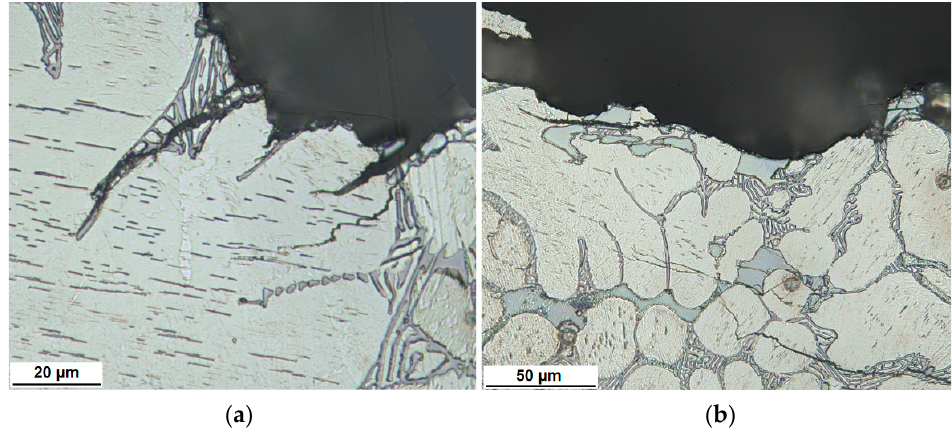
Figure 12. Cross-sectional micrographs of fracture surface after fatigue load (R = − 1, 12,000 cycles) showing crack branching of the sub-cracks near the main crack, within the dendritic α -Mg matrix ( a , b ).